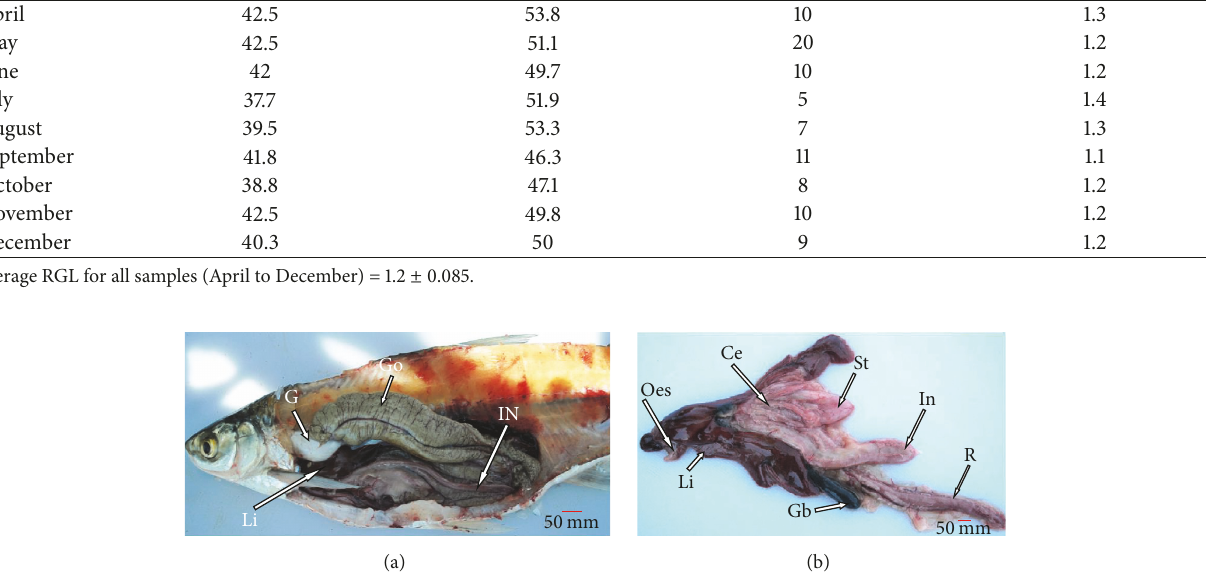
Figure 3: (a) Topography of the GIT and associated organs: gonad (Go), gas bladder (G), liver (Li), and intestine (IN). (b) Organs of the GIT: oesophagus (Oes), liver (Li), rectum (R), stomach (St), intestine (In), gall bladder (Gb), and caeca (Ce).